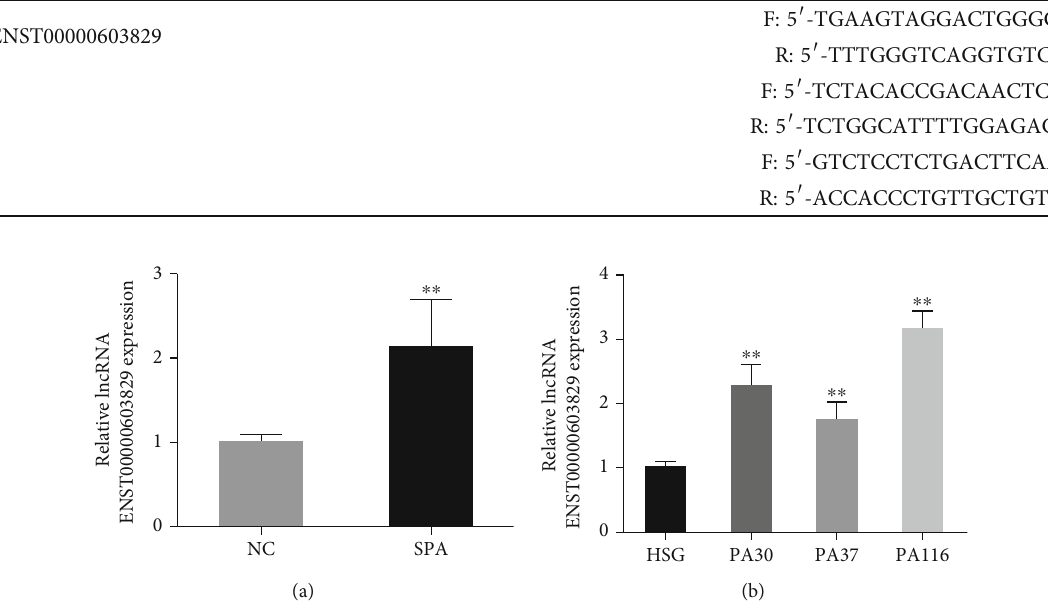
Figure 1: lncRNA ENST00000603829 expression in SPA tissues and cells. lncRNA ENST00000603829 expression in SPA (a) tissues ( ∗∗ p < 0 : 01 vs. the NC group) and (b) cells ( ∗∗ p < 0 : 01 vs. the HSG group) determined by